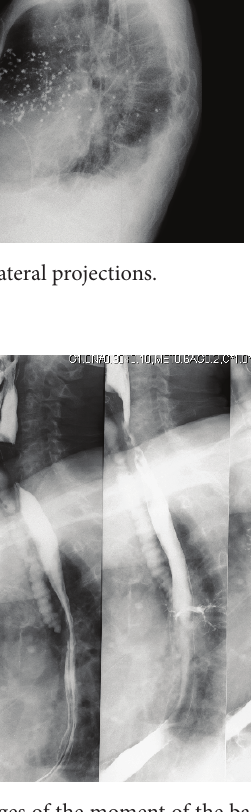
Figure 2: Images of the moment of the barium contrast aspiration during the gastrointestinal